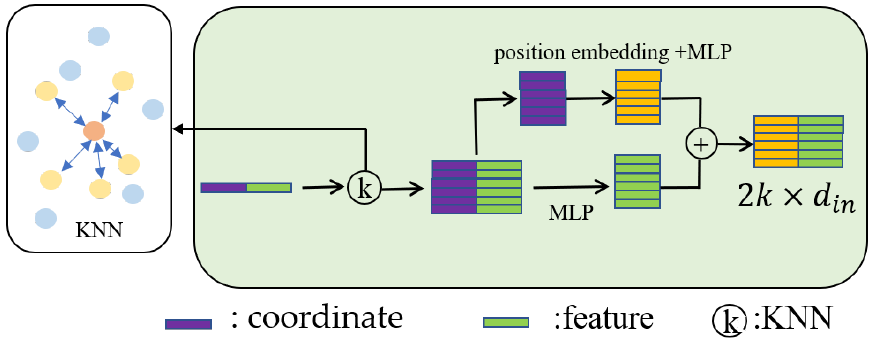
Figure 3. Neighbor embedding module.